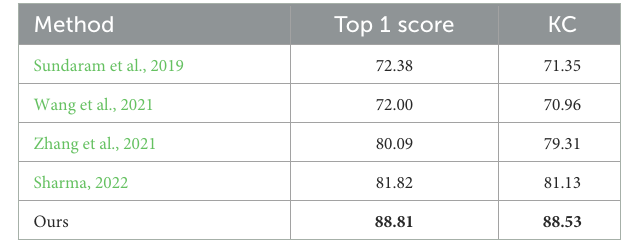
TABLE 4 Comparisons with the state-of-the-art methods in terms of top 1 score ( % ) and KC ( % ) on the MIT-STAG dataset.